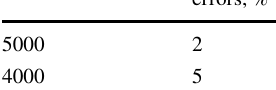
Table 5 Average petrophysical specification of single-layer reservoir model